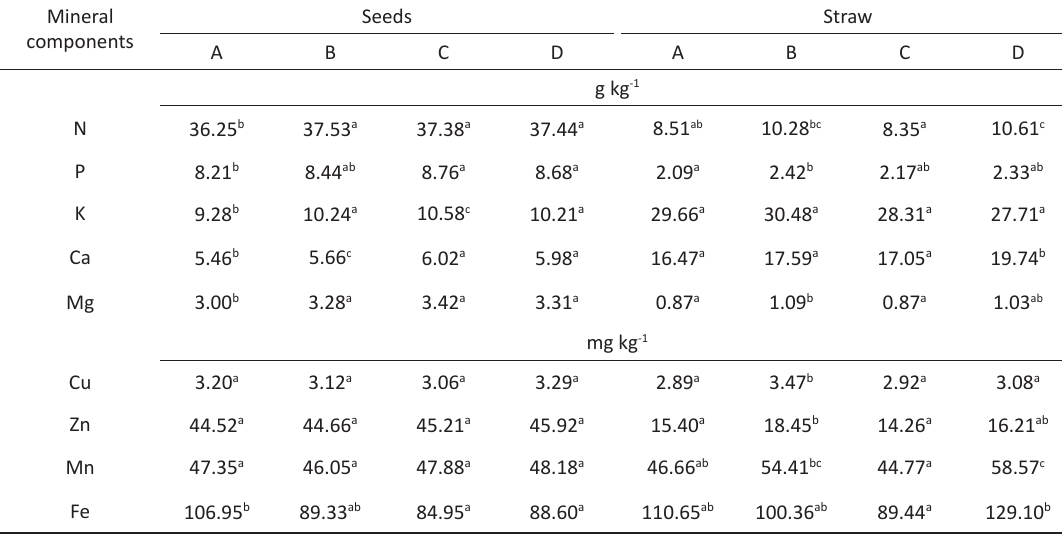
Table 5. Macro- and micronutrient content in winter oilseed rape (BBCH 89) Mineral components